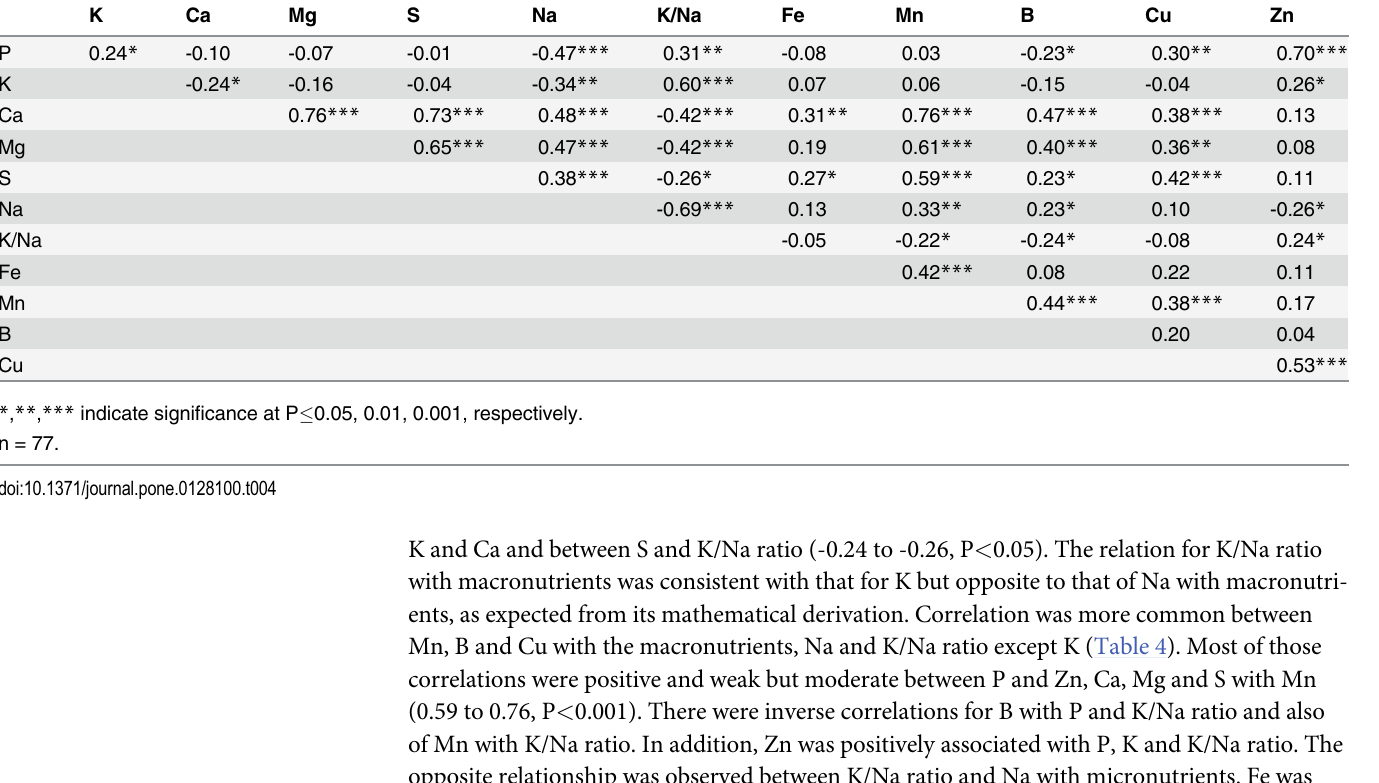
Table 4. Pearson correlation coefficients among macro-, micro-nutrient and Na concentrations and K/Na ratio on leaves of the RIL population based on a combined analysis of two